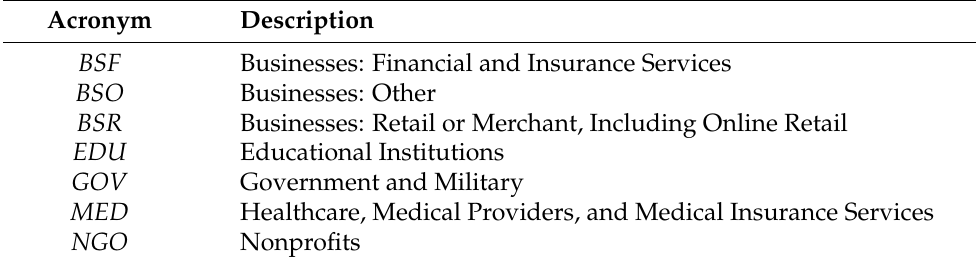
Table 1. The organization type of the companies falling victim to the data breaches considered with their